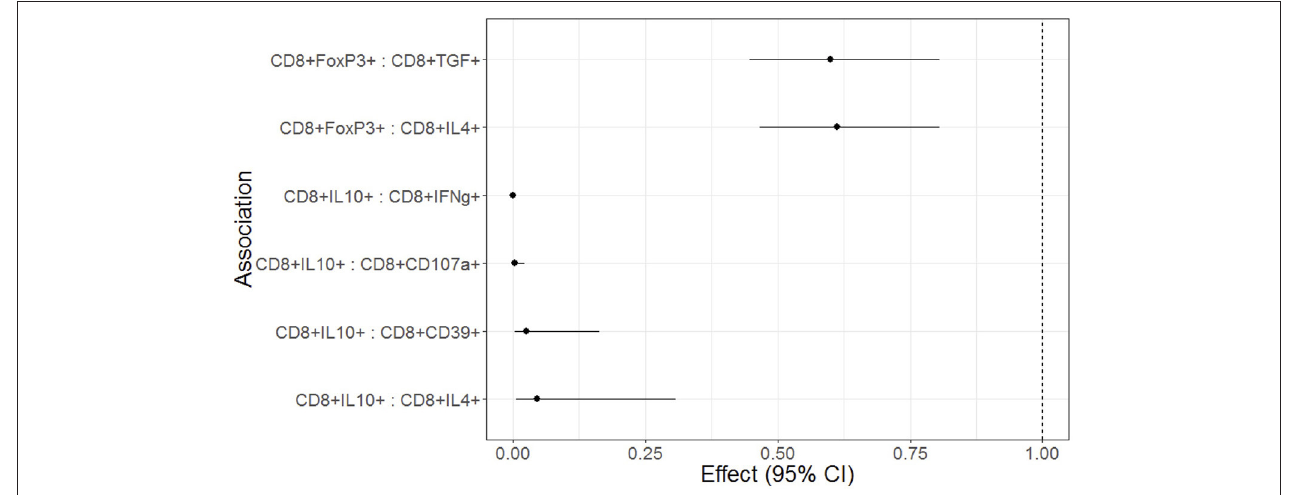
FIGURE 3 | Forest plot representation of significant effects of Treg on functional T cell outcomes in HEU and HUU. Data were derived from 6 HEU and 16HUU. Filled circles and horizontal lines indicate mean and 95% CI of the effect of each Treg population on the functional outcome indicated on the abscissa (Treg : functional outcome). No effect is indicated by the dotted vertical line. The effect represents the decrease of the functional outcome with each unit increase in the Treg population. For example, for each 1% increase in CD8 + FOXP3 Treg, there is a 40% decrease in the CD8 + TGF β T cells; and for each 1% increase in CD8 + IL10 + Treg there is a 95% decrease in the CD8 + IFN γ + T cells.